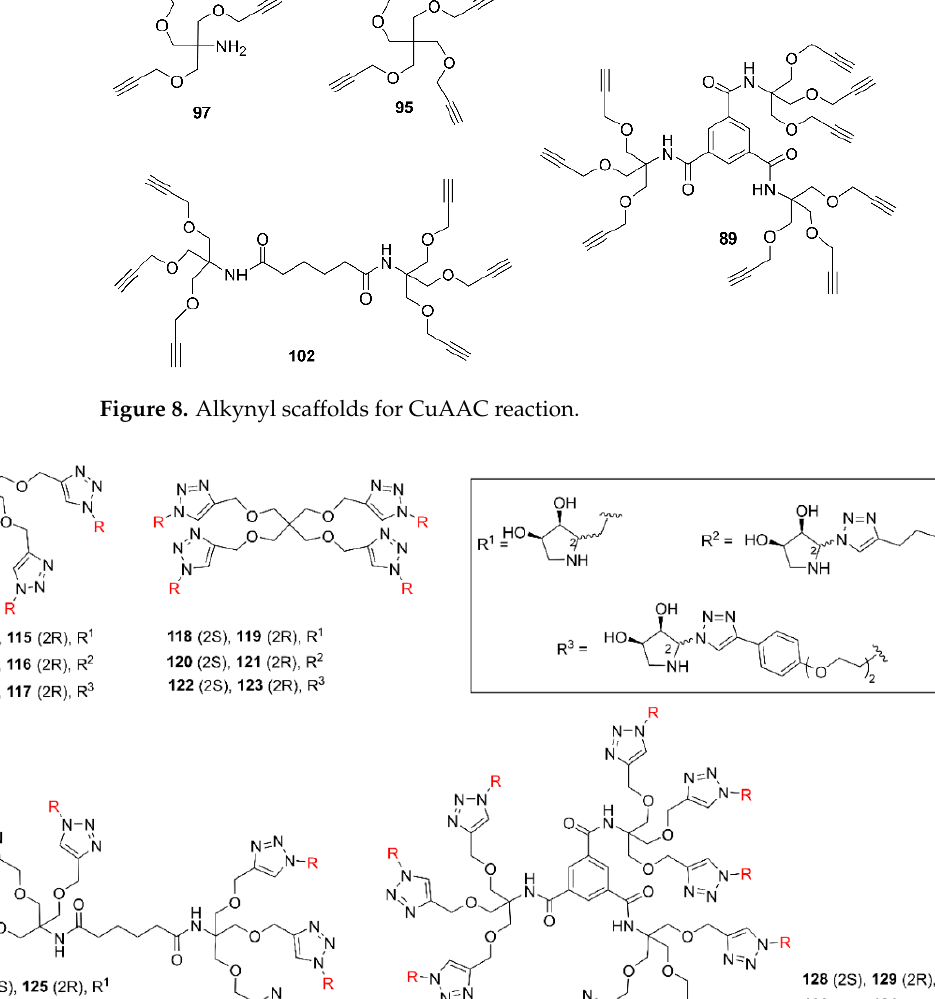
Figure 8 . Alkynyl scaffolds for CuAAC reaction.